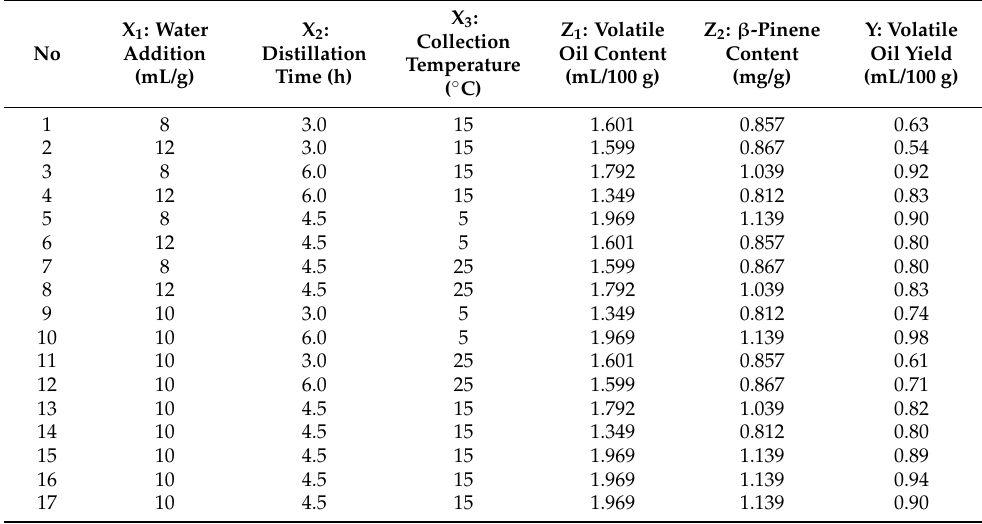
Table 4. The results of the Box–Behnken